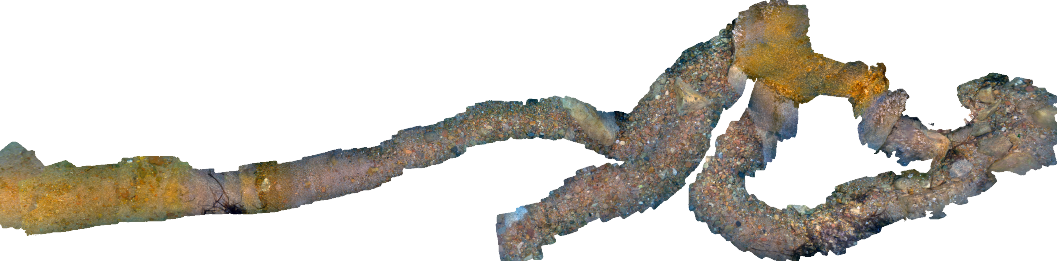
Figure 14. An example of the long trajectory 3D reconstructed model using images captured with the ROV-attached system. Such trajectories were used as ground truths to validate and tune the proposed